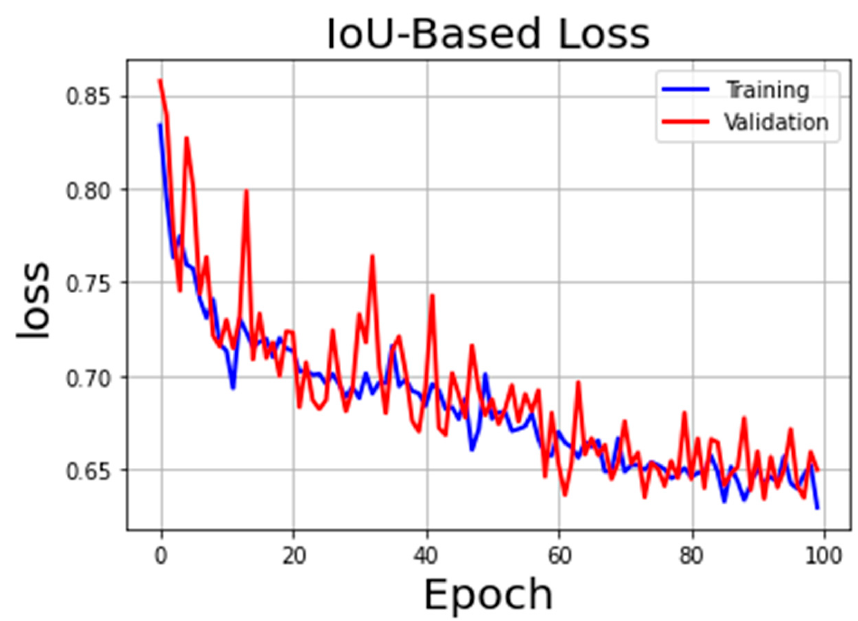
Figure 7. F1-Score during training and validation using Focal Loss.